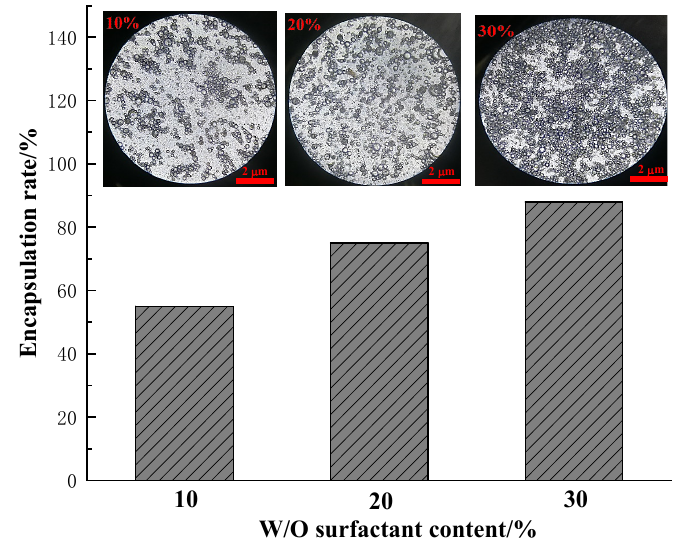
Figure 7. Encapsulation rate as related to W/O surfactant loading.